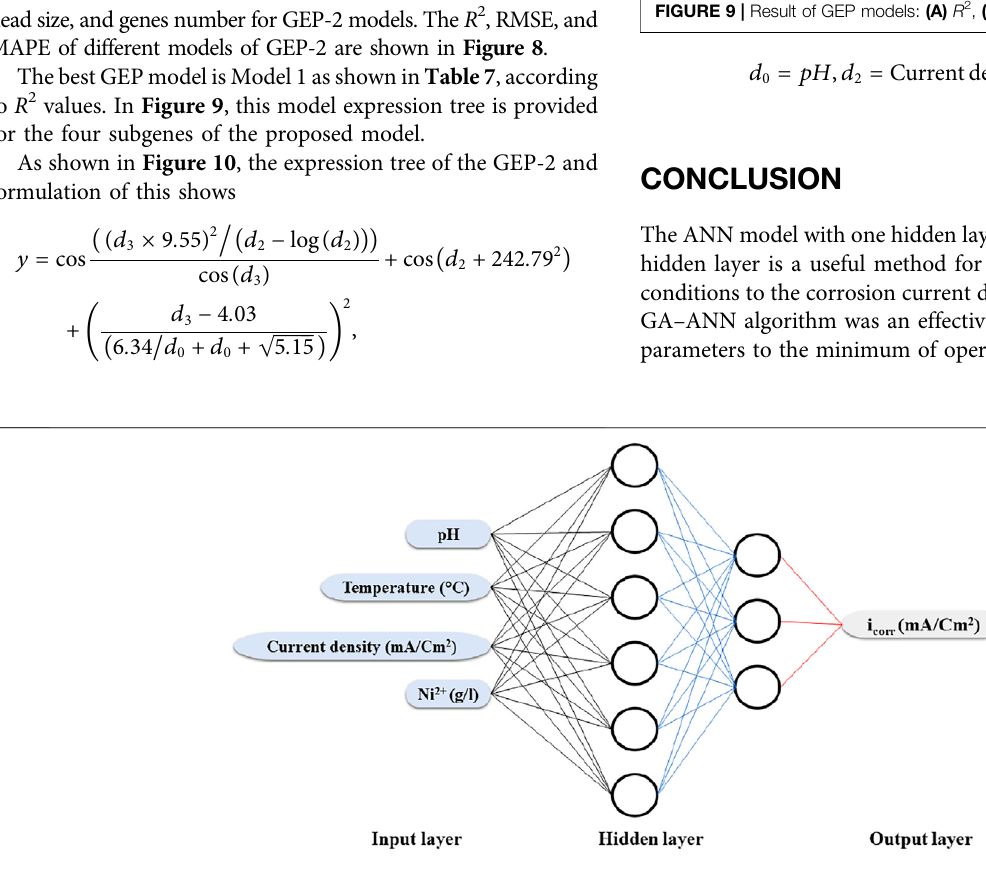
FIGURE 8 | Signi fi cances of input variables in mechanical properties.